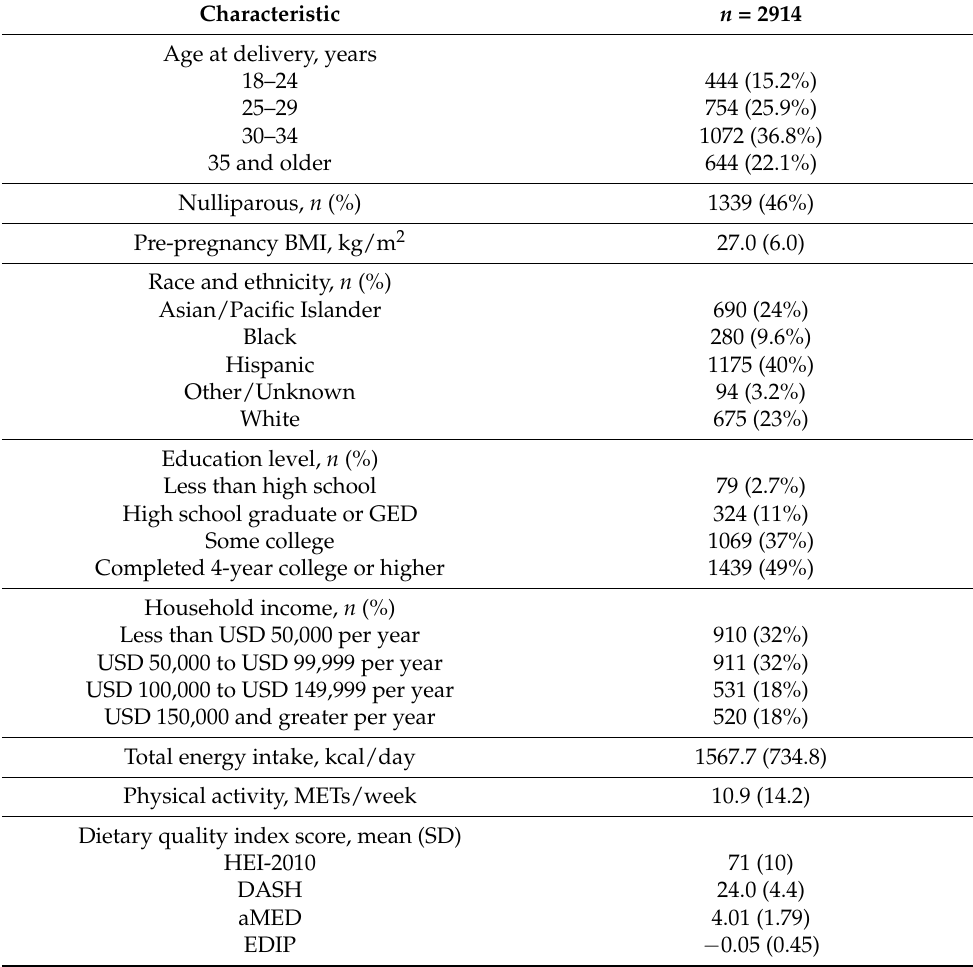
Table 1. Demographic characteristics of 2914 women in the Pregnancy Environment and Lifestyle Study (PETALS) who delivered between 2014 and